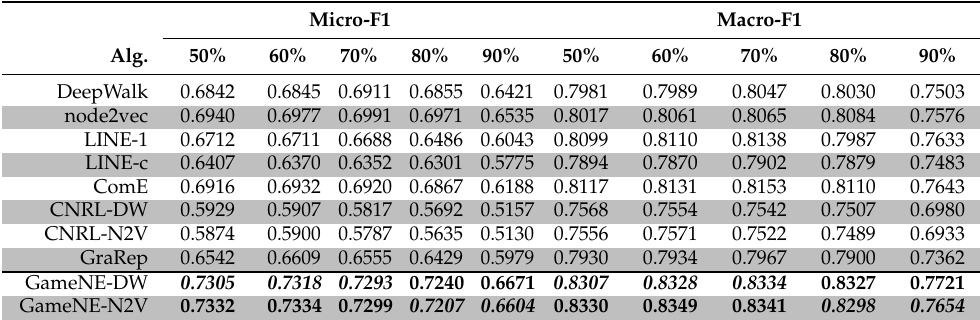
Table 4. Micro- and Macro-F1 Scores of Multi-Label Classification, Network om = 6.